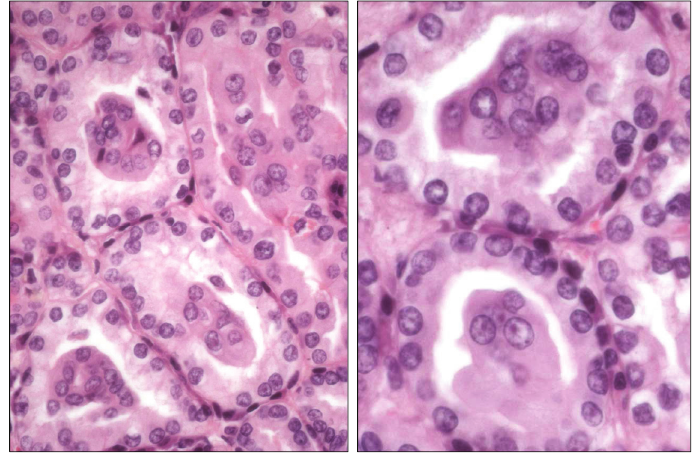
Figure 3. Microscopic detail of the alveolar structures containing small groups and single large squamoid cells ( A and B